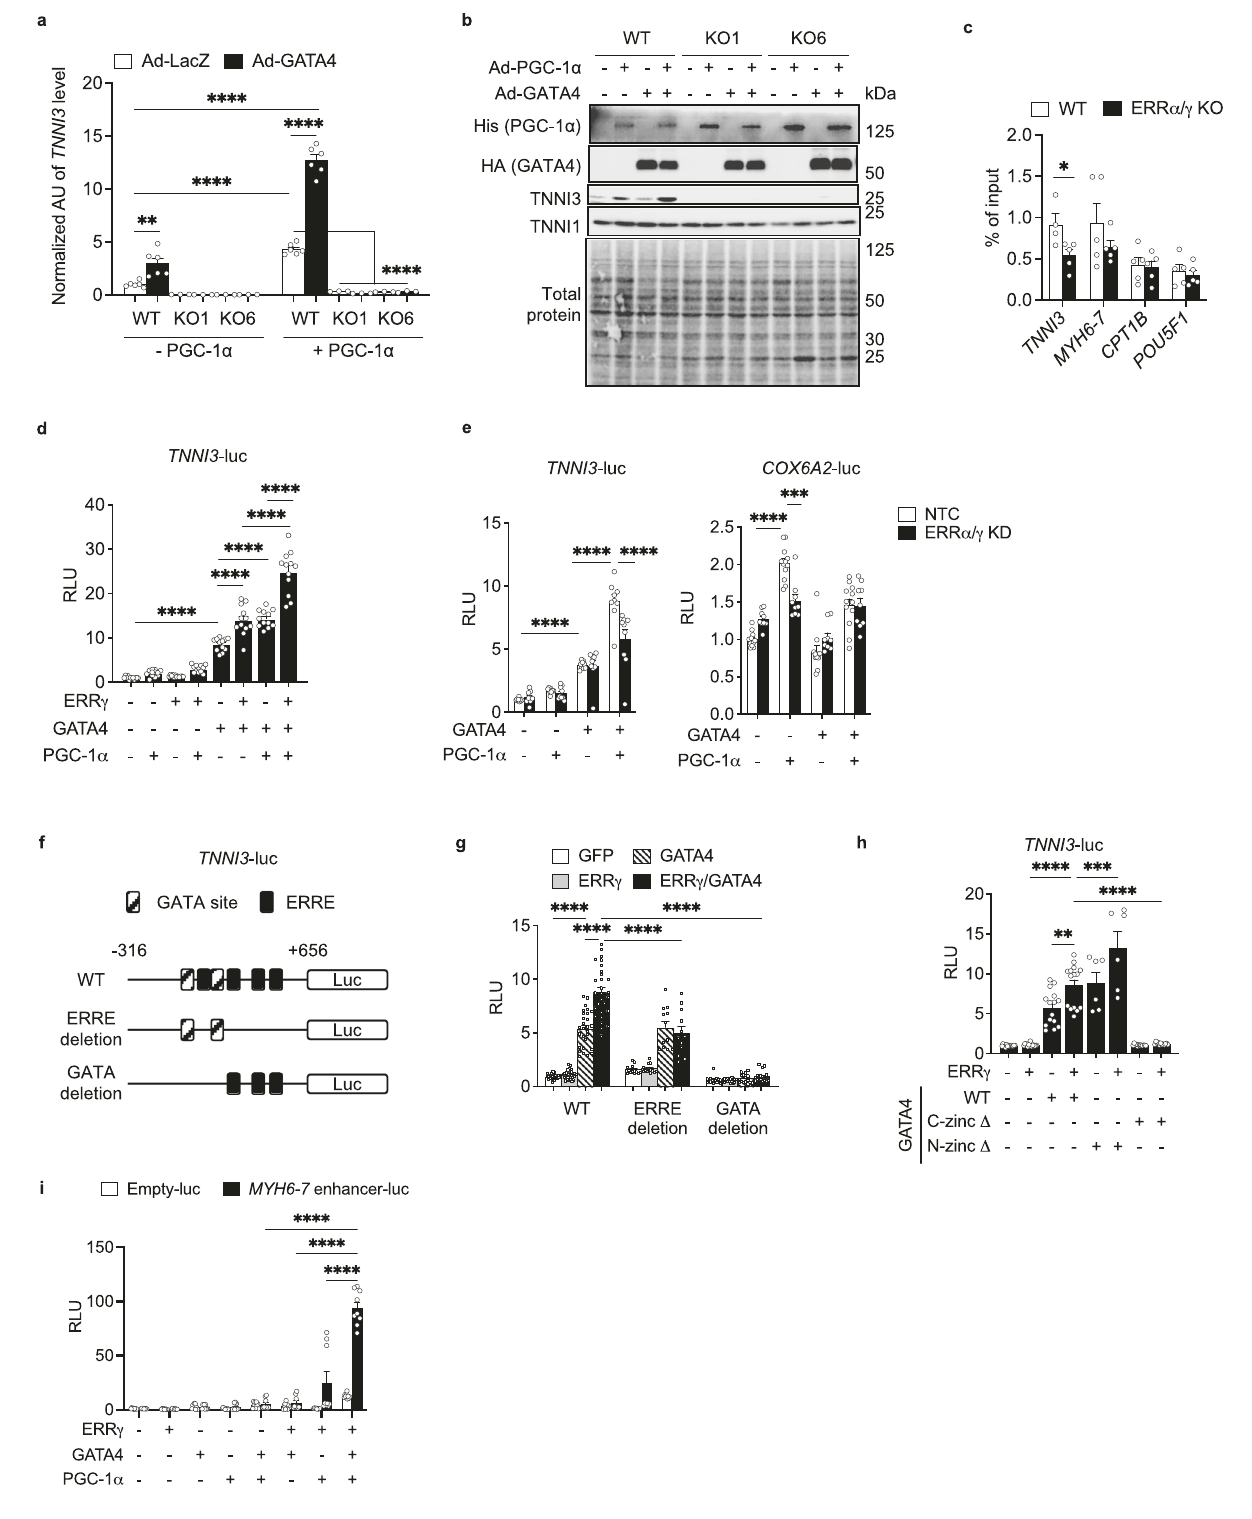
mutation GATA4 G296S and expression of downstream target genes was reduced in failing human heart samples. Together these results identify a mechanism whereby mitochondrial ATP- producing capacity is coordinately regulated with cell-speci fi c energy-consuming processes via cooperativity between a nuclear receptor, a cardiogenic transcription factor, and a common cor- egulator (Fig.